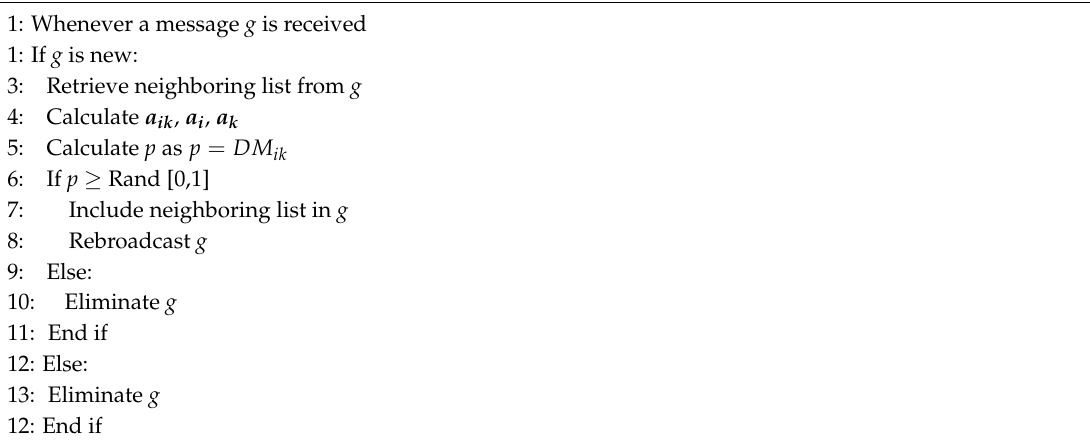
Algorithm 2. P-persistence algorithm based on dissimilarity